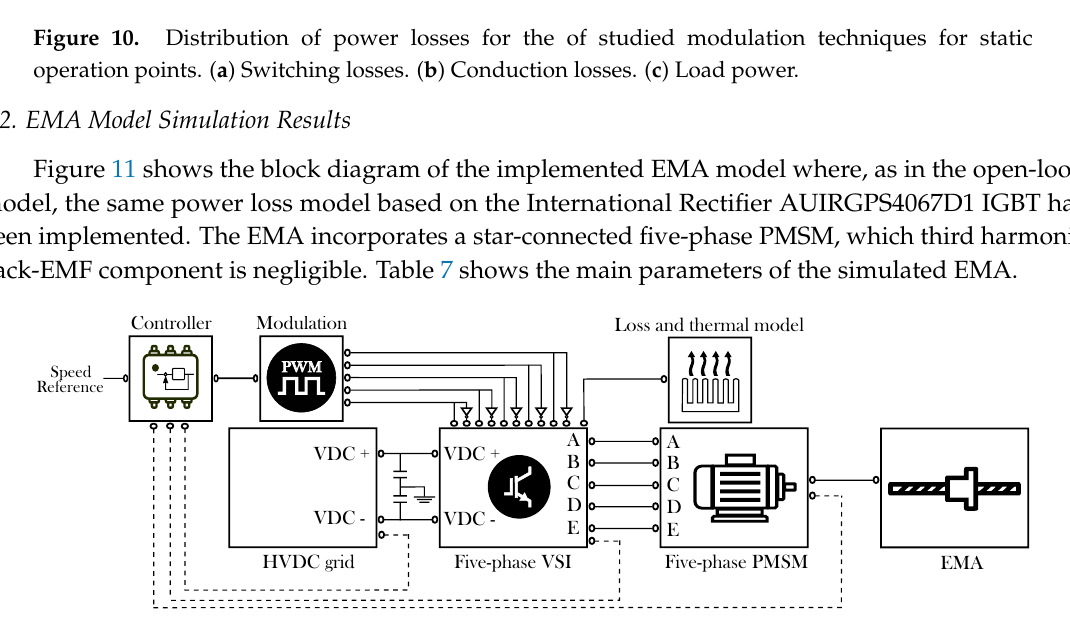
Figure 11. General block diagram of the electromechanical actuator (EMA) simulation